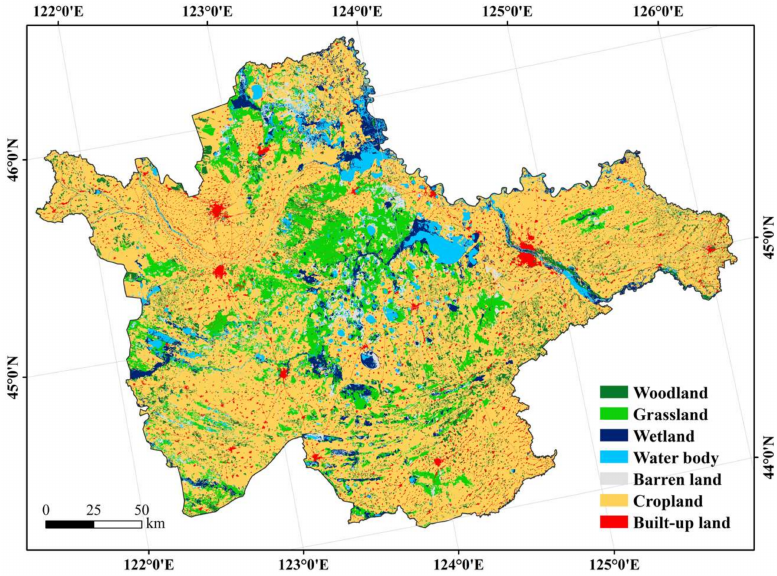
Figure 5. Spatial distribution of land cover in the west